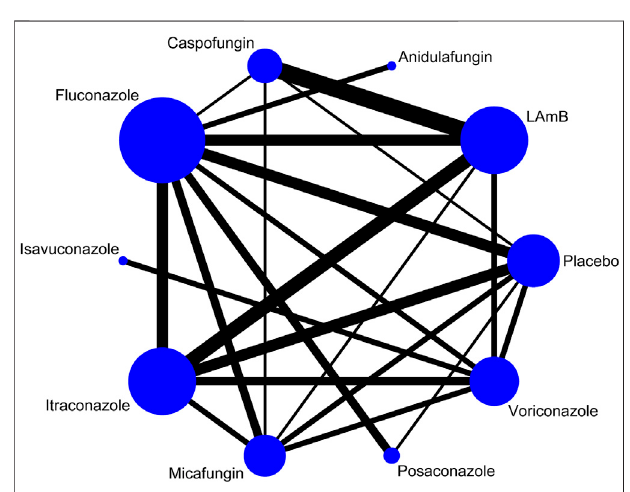
FIGURE 2 | Network plot for tolerability